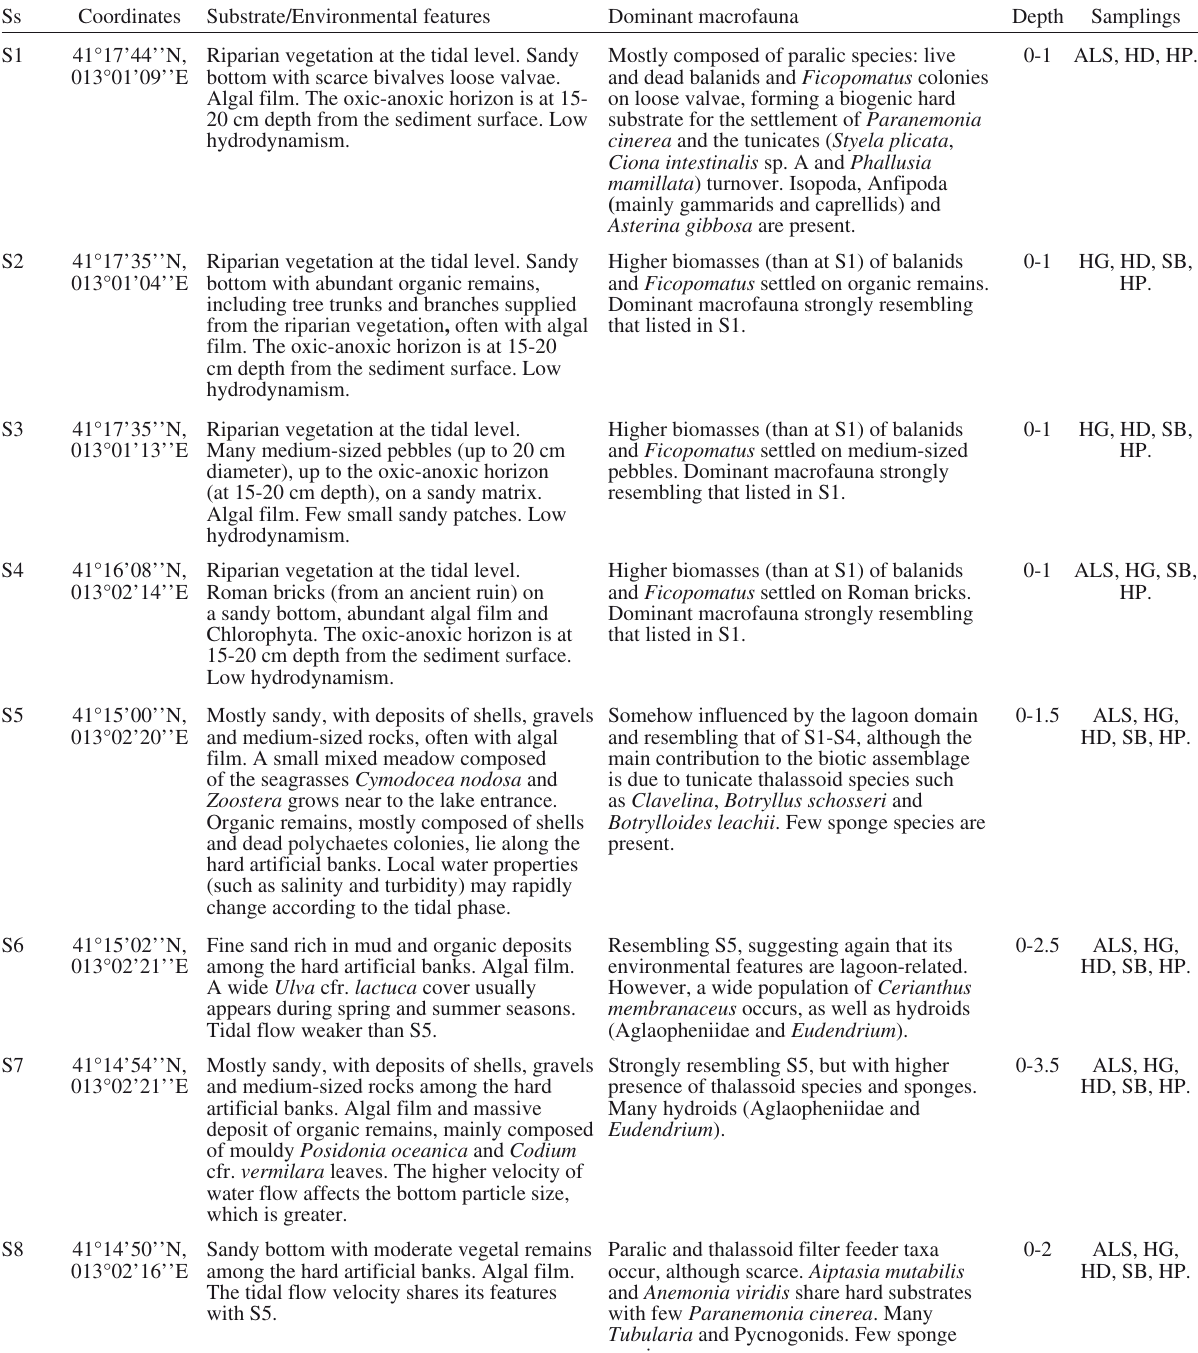
Table 1. – Sampling sites (Ss; see also Fig. 1B, C): coordinates, substrate/environmental features, dominant macrofauna (molluscs excluded), depth ranges (in metres) and sampling equipment (or techniques) used [air-lift sampler, ALS; hand dredge, HD; hand grab, HG; surface brushing, SB; hand picking, HP]. Coordinates Substrate/Environmental features Dominant macrofauna Depth